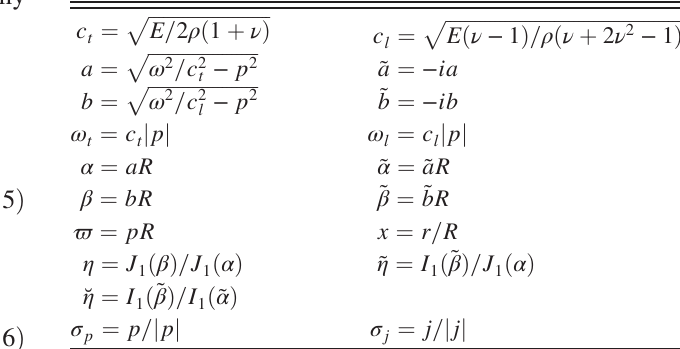
TABLE IX. Definitions of the longitudinal and the transverse sound velocity c and c , as well as the radial constants a and b , l t and the dimensionless quantities appearing in the phonon modal fields. The definitions are given in terms of the density ρ , Young's modulus E , Poisson ration ν , fiber radius R , azimuthal order j , propagation constant p , and radial position r